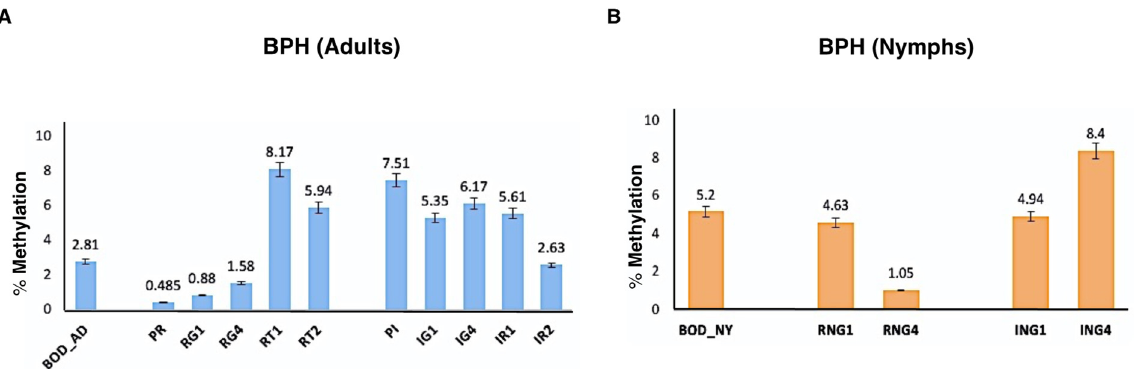
Figure 2. Comparison of global DNA methylation profiles of BPH populations. ( A ) Changes in DNA methylation, upon exposure to pesticide and nutritional stress, in BPH adults ( B ) Response of BPH nymphs with regard to the genome-wide alterations in their DNA methylation levels upon exposure to stress. Error bar represents SD.